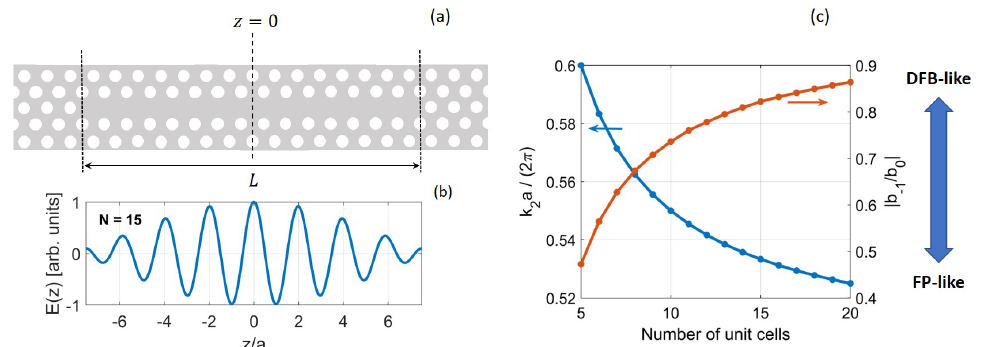
Figure 9. ( a ) L15 cavity and ( b ) electric field profile of the fundamental resonant mode. ( c ) Resonance condition of LN cavities: normalized wavevector k 2 ( left ) and magnitude of the ratio between the Bloch modes spatial harmonic b − 1 and spatial average b 0 ( right